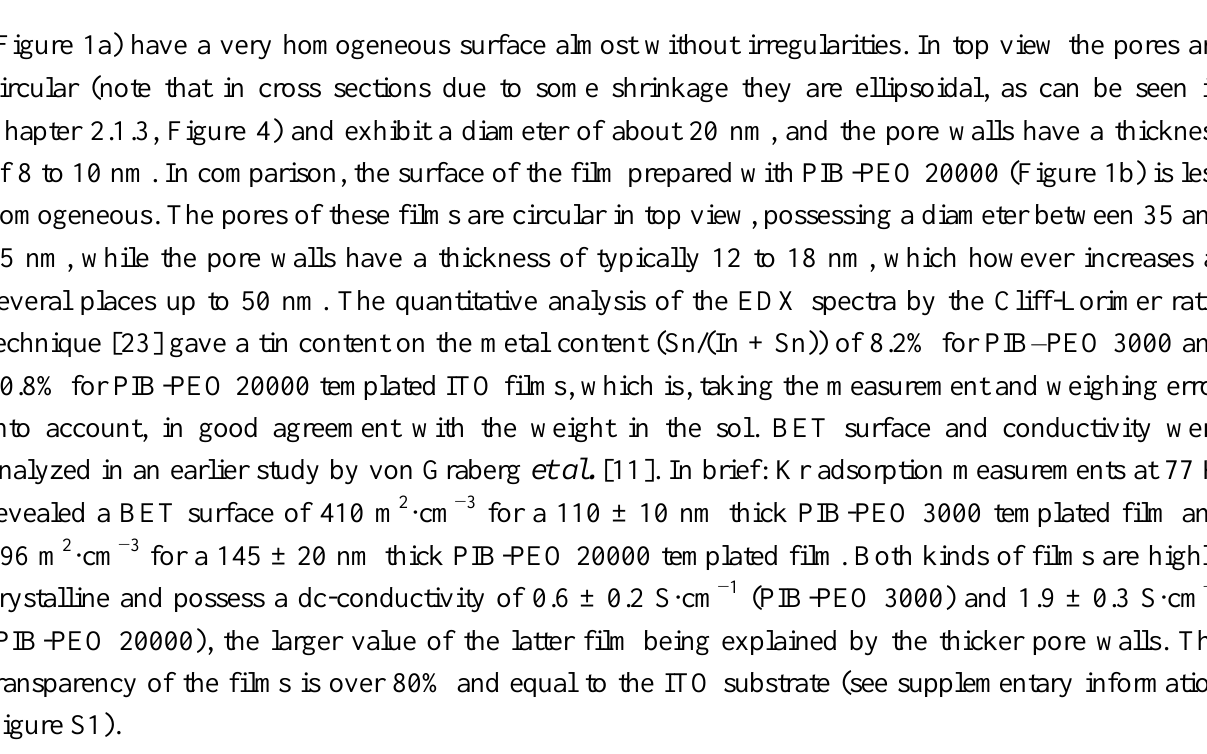
Figure 1. SEM images of mesoporous indium tin oxide (ITO) films templated with the block copolymers PIB-PEO 3000 ( a ) and PIB-PEO 20000 ( b